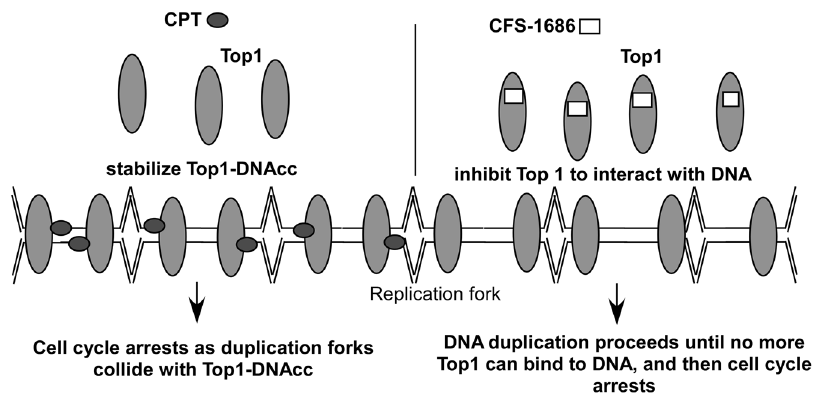
Figure 5. Proposed interaction mode of CPT or CFS with Top1 during DNA